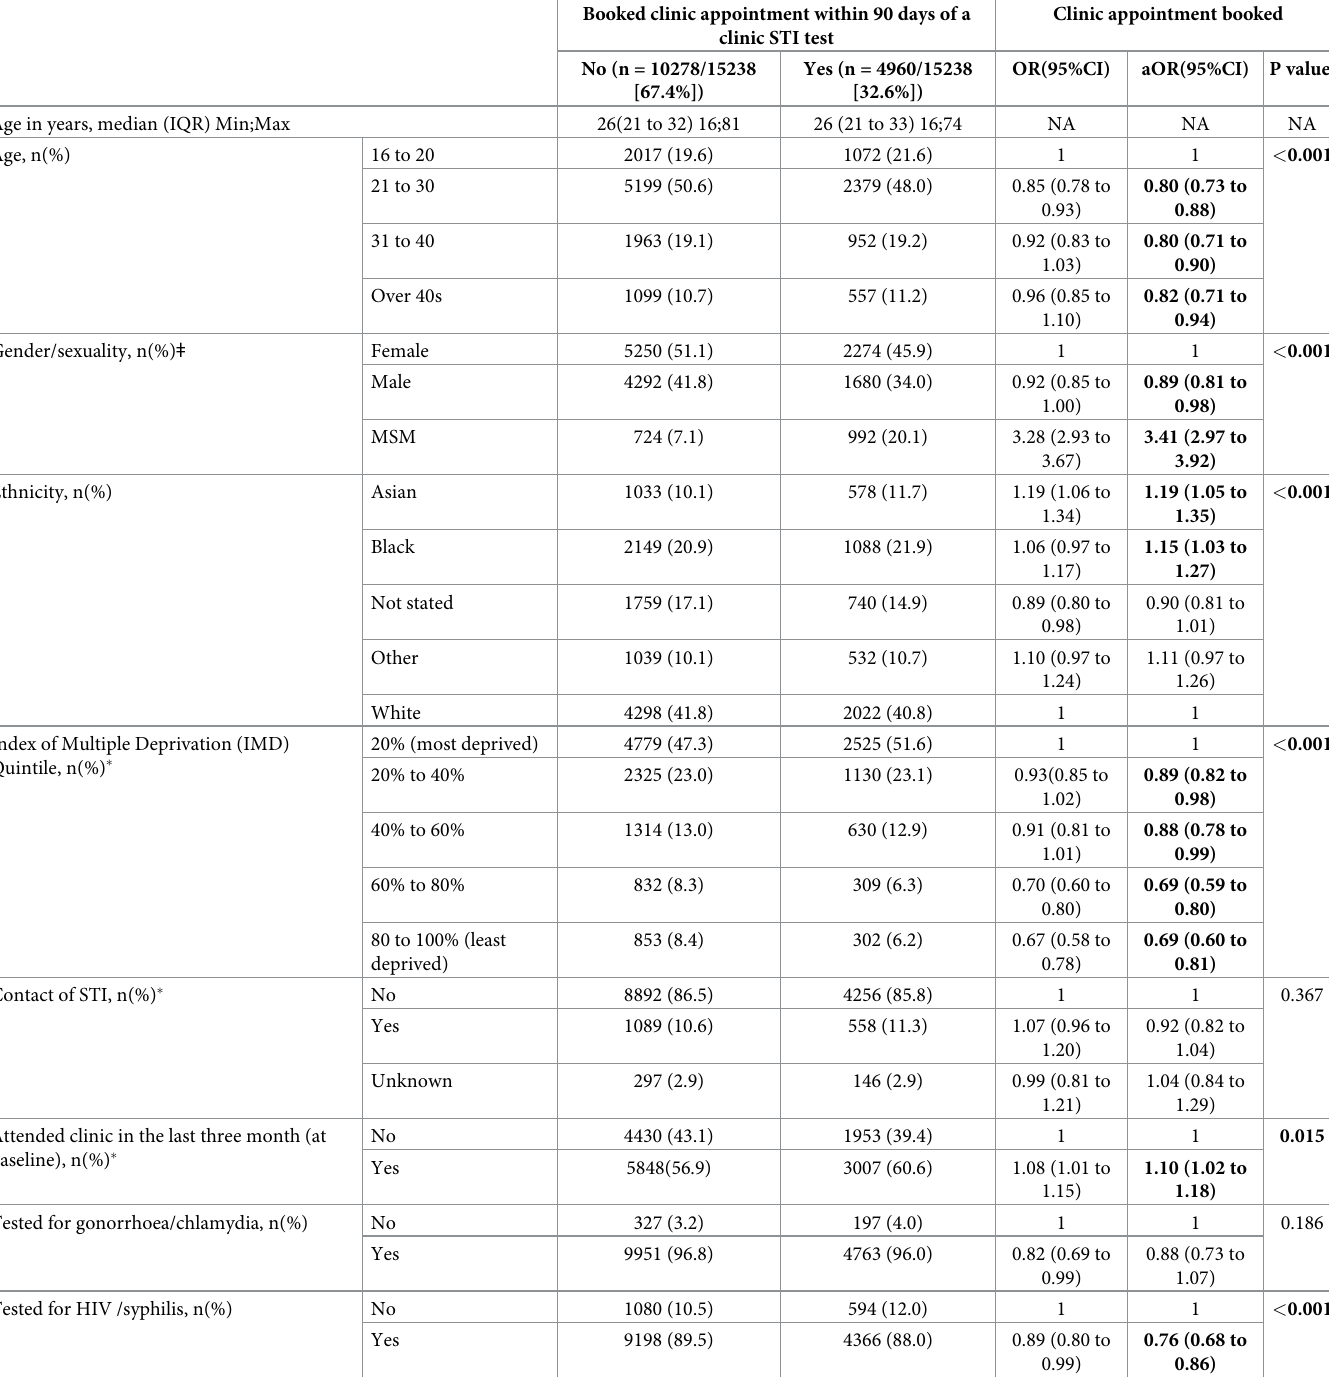
Table 4. Factors associated with sexual clinic booking appointment within 90 days of an asymptomatic clinic STI test (n =